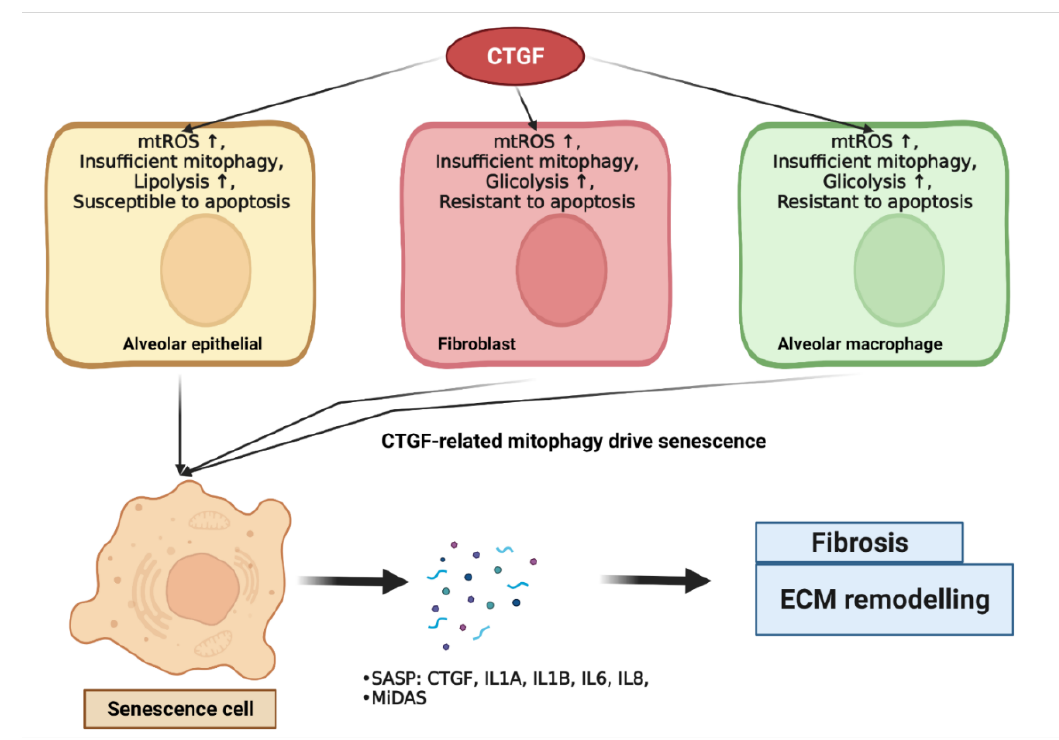
Figure 2. CTGF-regulated metabolic dysregulation and mitochondria dysfunction contribute to cellular senescence. CTGF drives metabolic- and mitochondria-dysfunction-associated mitophagy and contributes to cellular senescence. Briefly, CTGF expression in IPF cells leads to ROS production, metabolism disturbance, and paradoxical apoptosis, leading to mitophagy induction. Autophagy drives the onset of senescence. Senescent IPF lung epithelial cells, fibroblasts, and myofibroblasts se- crete CTGF as pro-inflammatory SASP to induce senescence-associated fibrotic effects in surrounding cells via paracrine and autocrine signaling. Oxidative stress, autophagy, and senescence may also contribute to CTGF-induced fibrosis and ECM